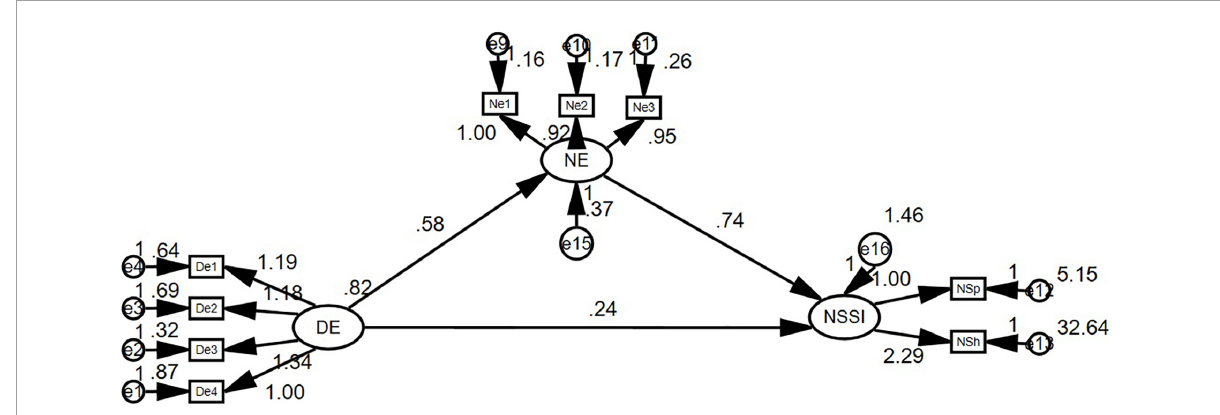
FIGURE2 Structural equation model fit test ( N = 401, where DE is catastrophising tendency, NE is a negative emotion, and NSSI is non-suicidal self-injury).